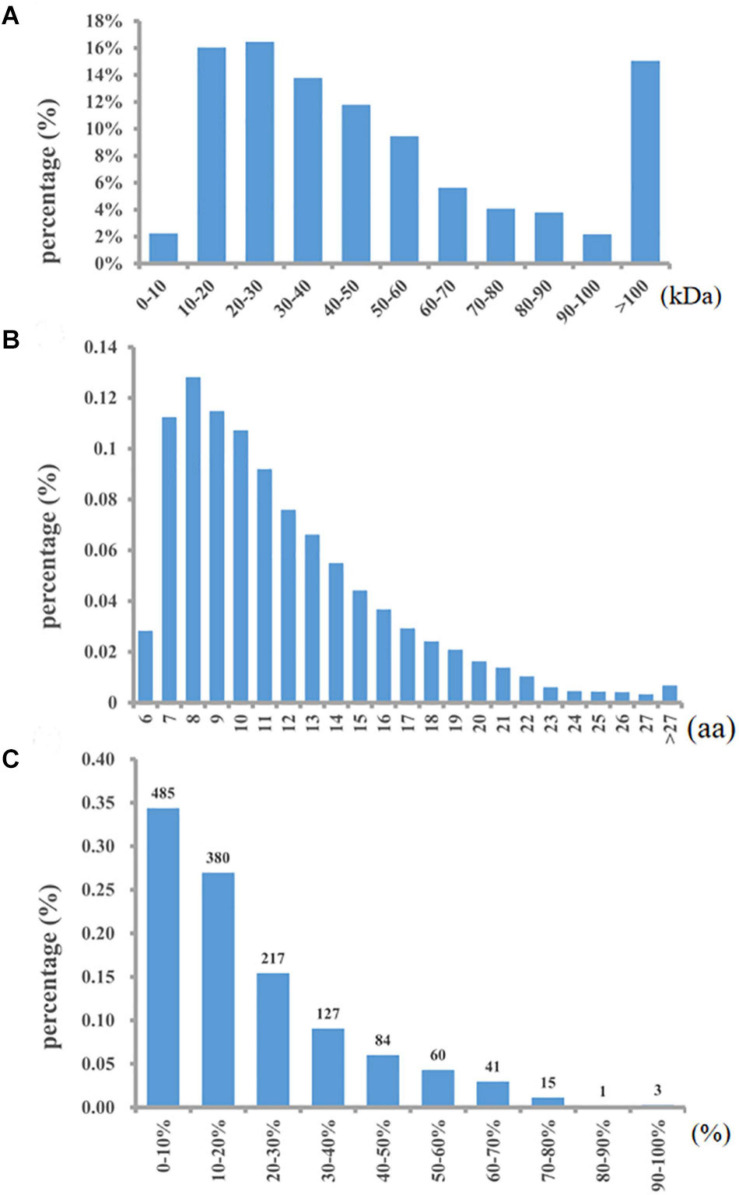
Distributions of all identified proteins. Mass (A), length (B), and coverage (C).